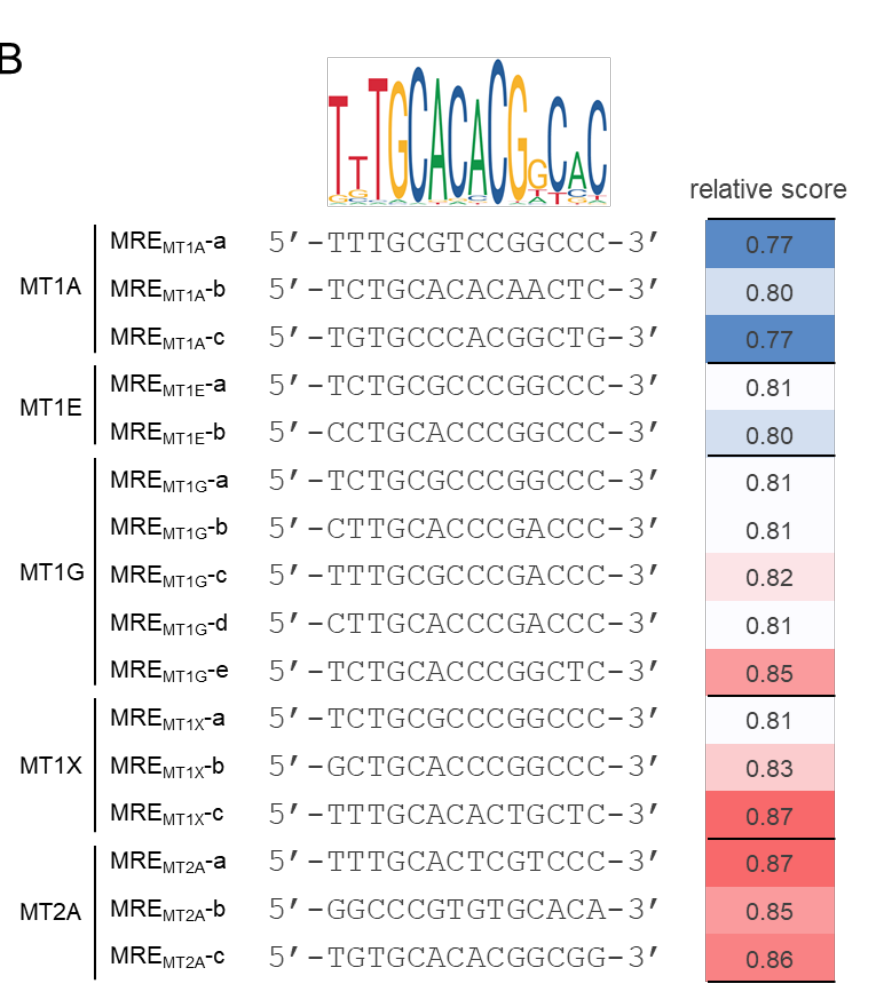
Figure 1. Schematic diagram of the MT promoter region. ( A ) The arrows indicate the transcription start sites. Orange and red squares indicate MREs (designated a–e, from the side closest to the transcription start site; the sequences in the red squares were used as competitor for EMSA assay) that is identified by the JASPAR search for MTF1 (Matrix ID: MA0863.1). The gray bold-lined area was cloned in the luciferase reporter vector. ( B ) Comparison between MRE consensus sequence and MRE sequences on each MT promoter. The relative scores obtained from the JASPAR search are shown in color scale on the